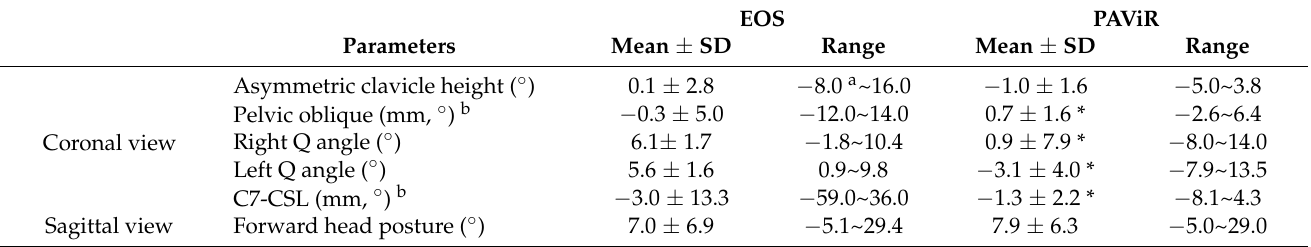
Table 2. Descriptive statistics of coronal and sagittal parameters obtained via the EOS and PAViR.